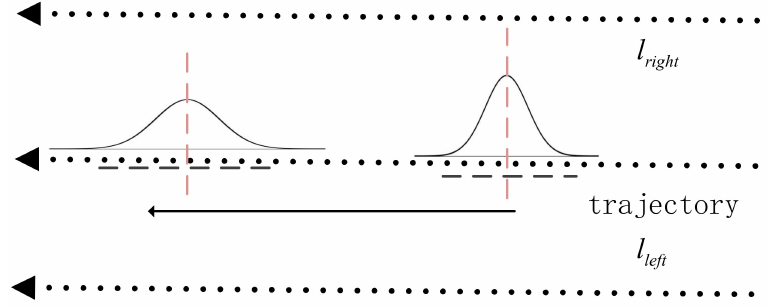
Figure 4. Probabilistic update diagram.